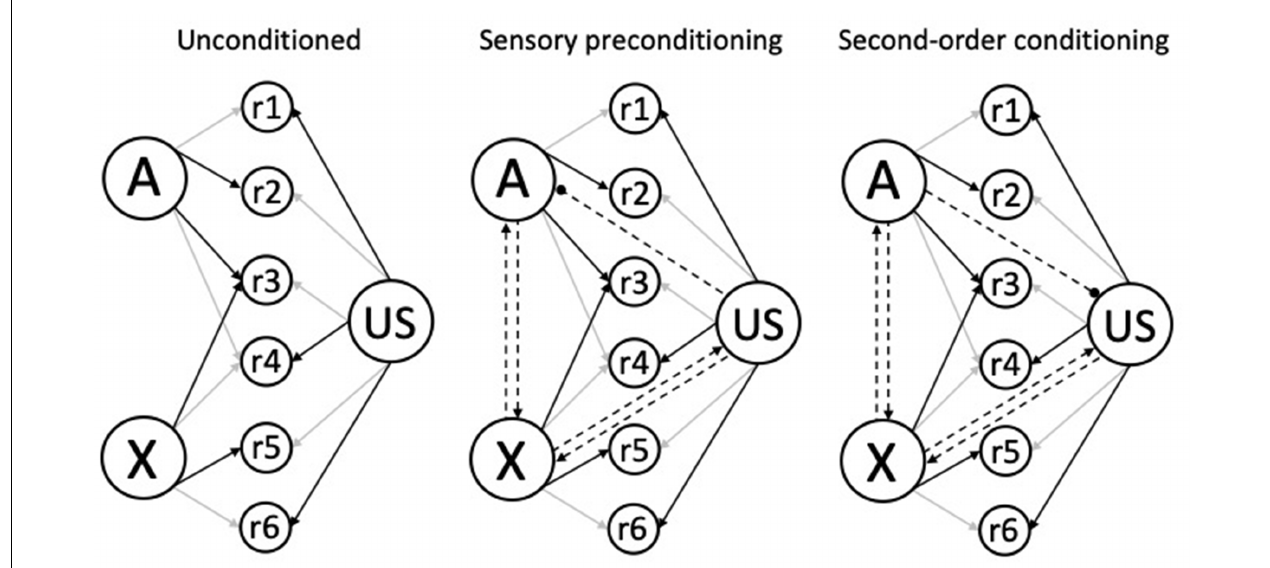
FIGURE 3 | Schematic associative structures for higher-order (excitatory) conditioning. The left structure shows the unconditioned links from the CSs (A and X) and the US to response-generating units (r1-r6) before conditioning. The darkness of the arrows indicates link strength: A is strongly linked to r2 and r3, B is strongly linked to r3 and r5; and the US is strongly linked to r1, r4, and r6; and the remaining unconditioned links are weak or absent. The central and right structures show the reciprocal associations between the A and X, and between the X and US nodes (denoted by the dashed lines with arrowheads), acquired during higher-order trials (e.g., A → X and X → US); with a directional inhibitory US → A association for sensory preconditioning (center panel) and an inhibitory A → US association in second-order conditioning (right panel; denoted by the dashed line with the circular end; based upon one interpretation of inhibitory learning). Adapted from Honey and Dwyer (under